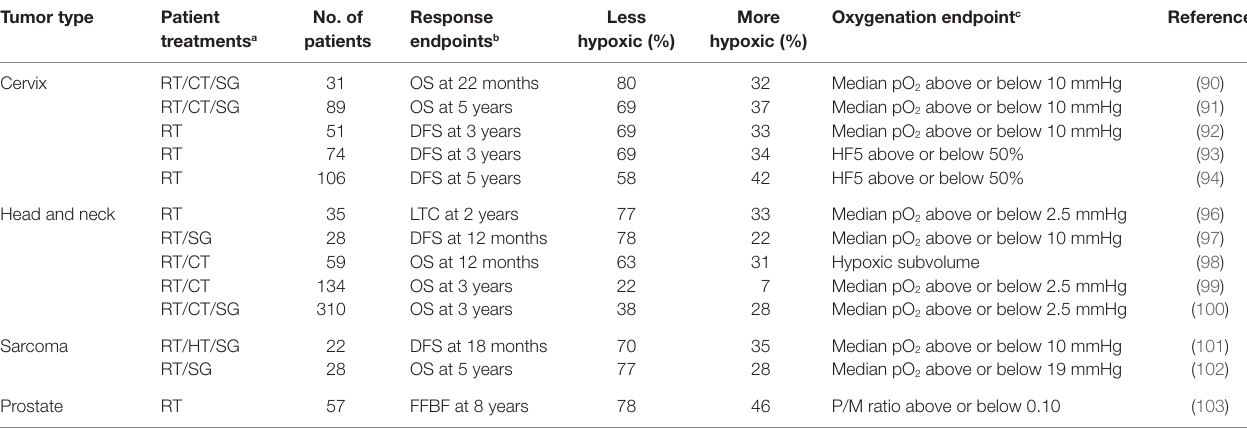
TABLe 2 | Relationship between tumor oxygenation estimated prior to therapy using the eppendorf histograph and outcome to therapy. Tumor type